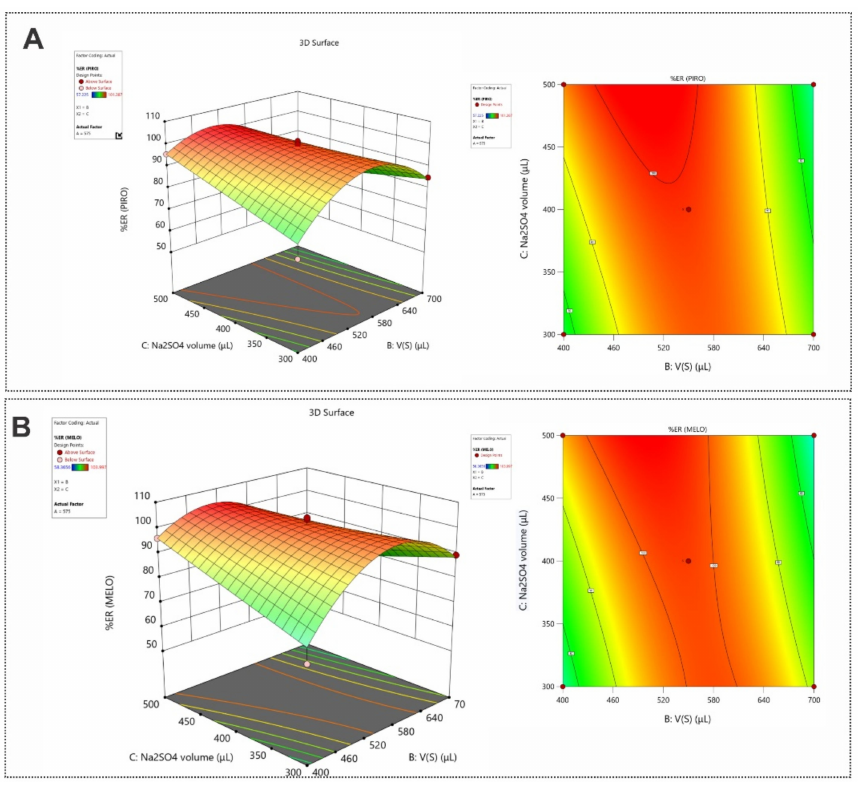
Figure 2. Three-dimensional response surface and contour plots for ( A ) PIR and ( B ) MEL determina- tion using BBD.